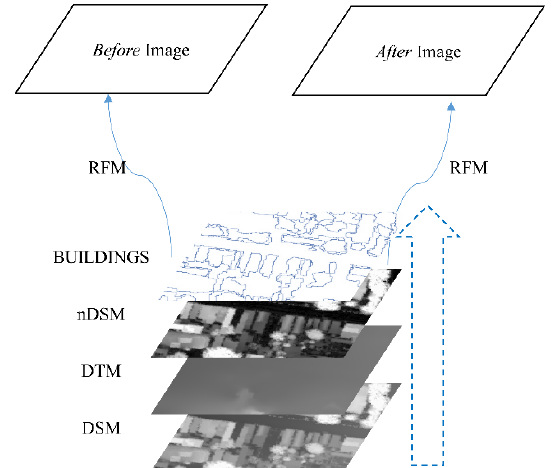
Figure 2: Extracting building segments and performing